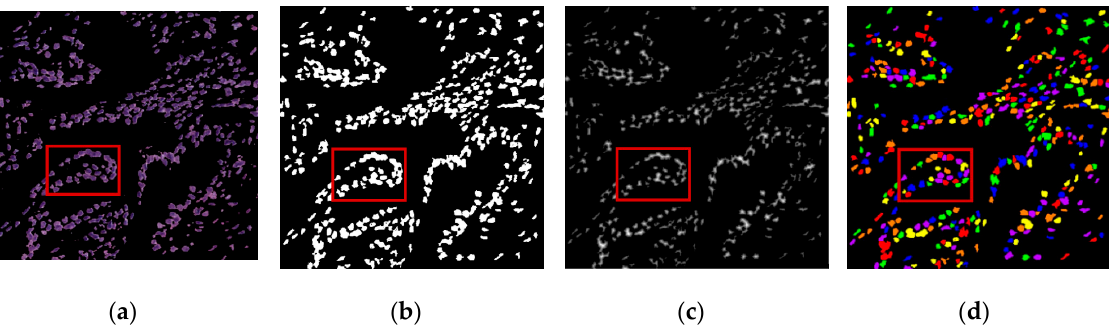
Figure 4. Overview of watershed segmentation: ( a ) original segmented image of nucleus tissue components; ( b ) noise-removed binary image; ( c ) Euclidean distance transform on binary image; and ( d ) result of the watershed algorithm and labelled nuclei using color mapping.